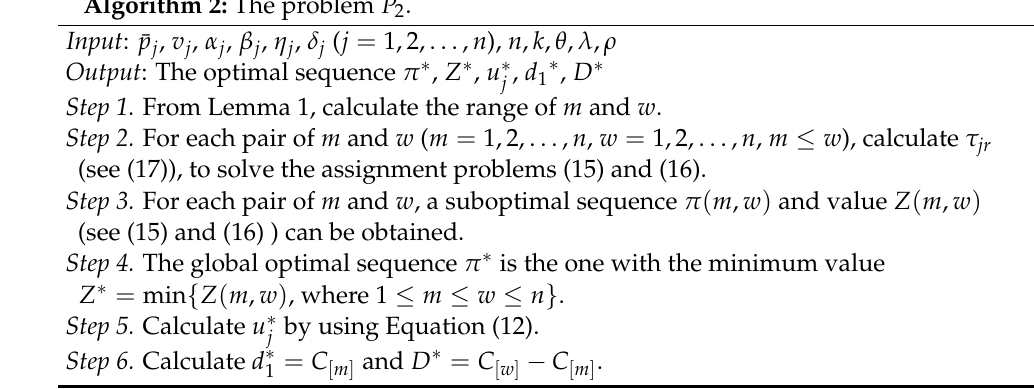
Algorithm 2: The problem P 2